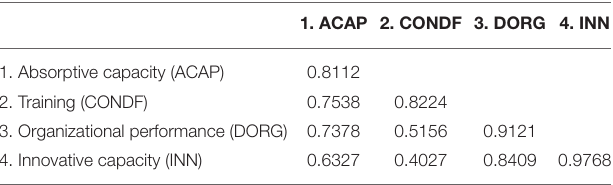
TABLE 7 | Inter-construct correlations matrix: discriminant validity (Model